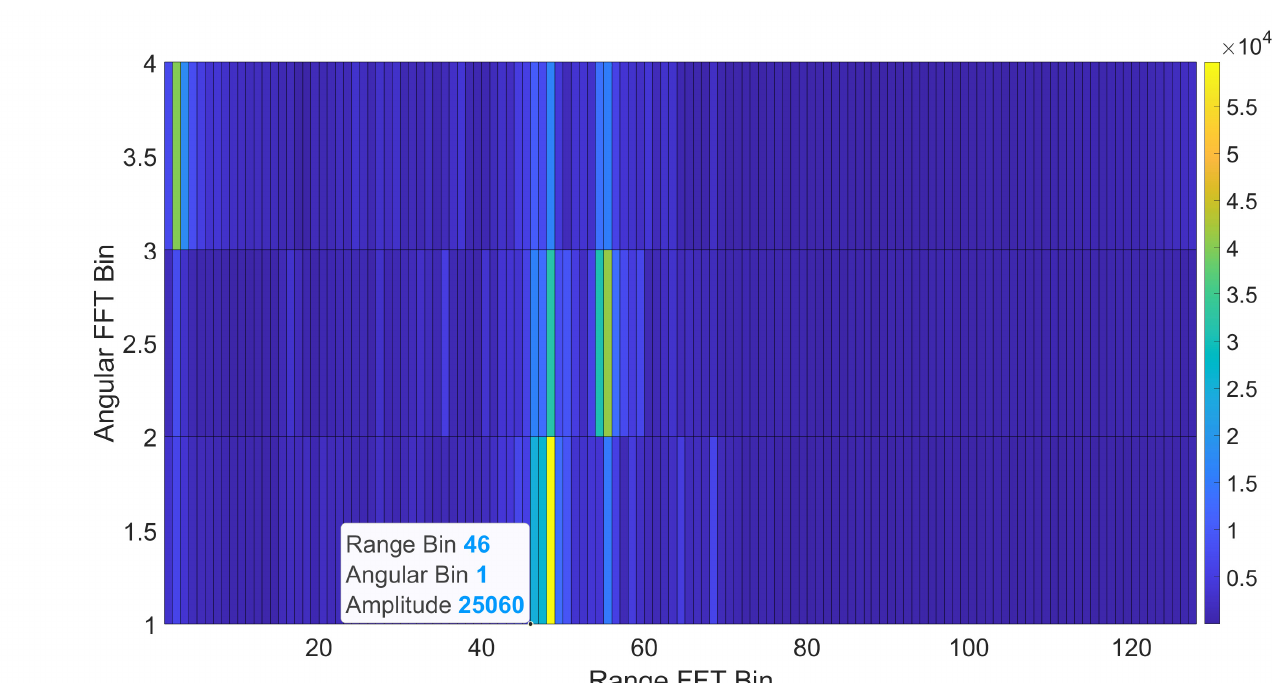
Figure 8. Range-angular direction